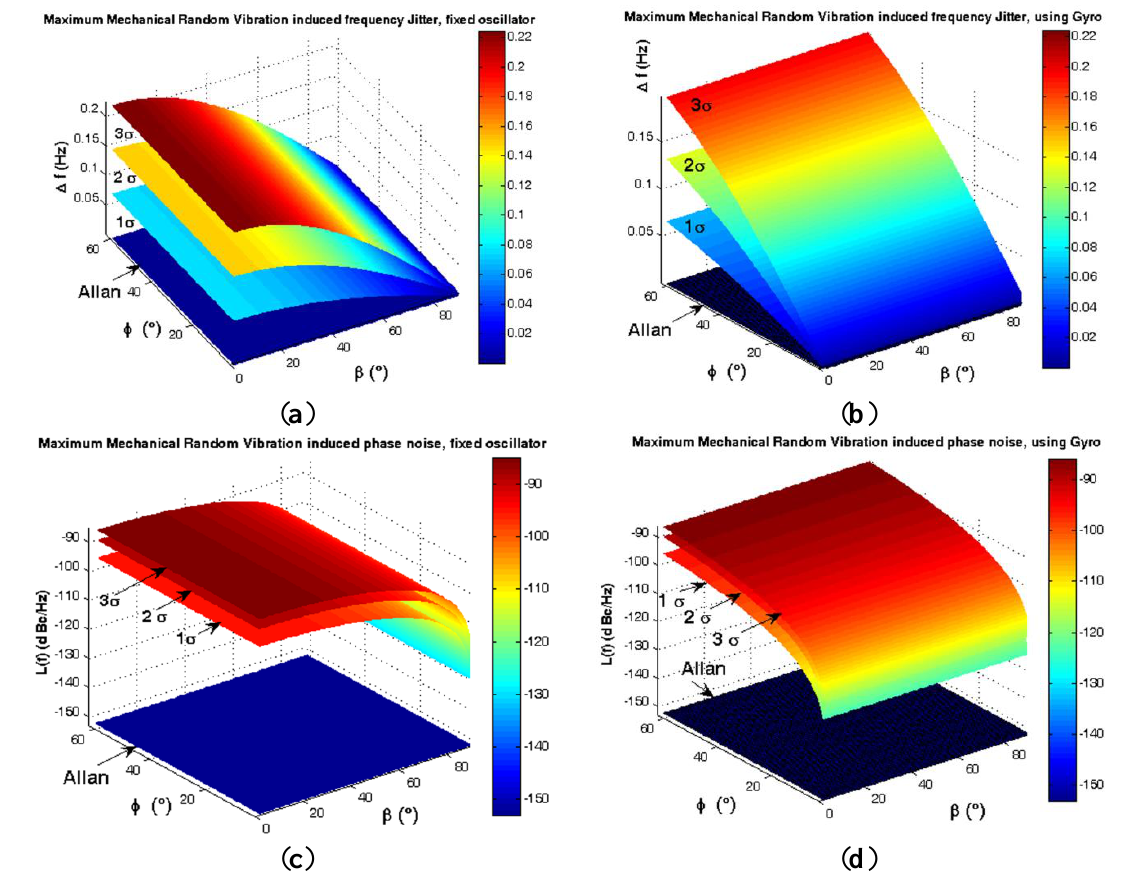
Figure 22. Maximum instability (ξ = φ) caused by random vibration for ƒ RV = 2000 (Hz). ( a ) Frequency jitter of fixed oscillator; ( b ) Frequency jitter of gyroscopic mounting; ( c ) Phase noise of fixed oscillator; ( d ) Phase noise of gyroscopic mounting.